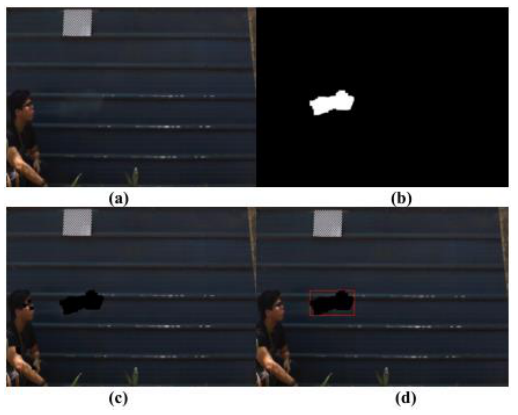
Figure 13. Peak Density of Cigarette Smoke in an Outdoor Environment at 1.2 seconds (30th Frame) (a) raw video frame (b) binarized video frame (c) masked video frame (d) the masked video with contour frame